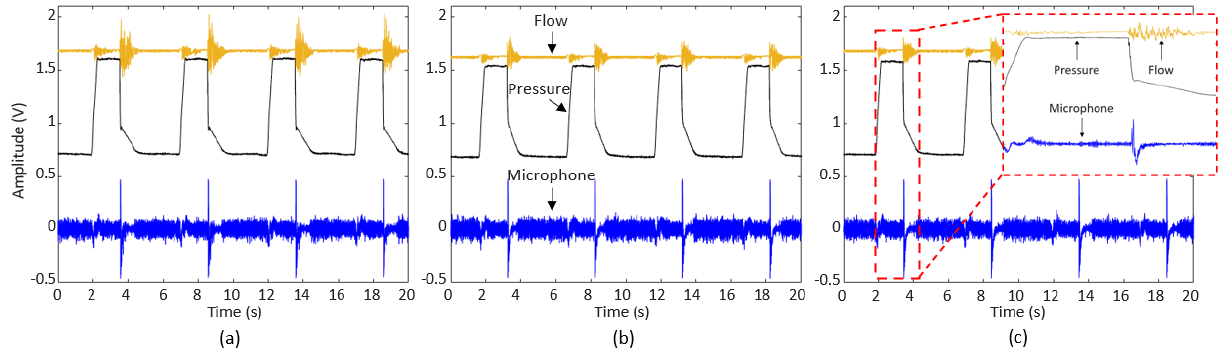
Figure 6. Pressure, flow rate, and microphone signals acquired from the sensor connector: ( a ) Section 1 (location of obstruction) with 50% (degree of obstruction) waveform, ( b ) Section 2 with 40% waveform, and ( c ) Section 3 with 20% waveform and highlighted results of extracting one respiratory cycle based on the pressure signal.